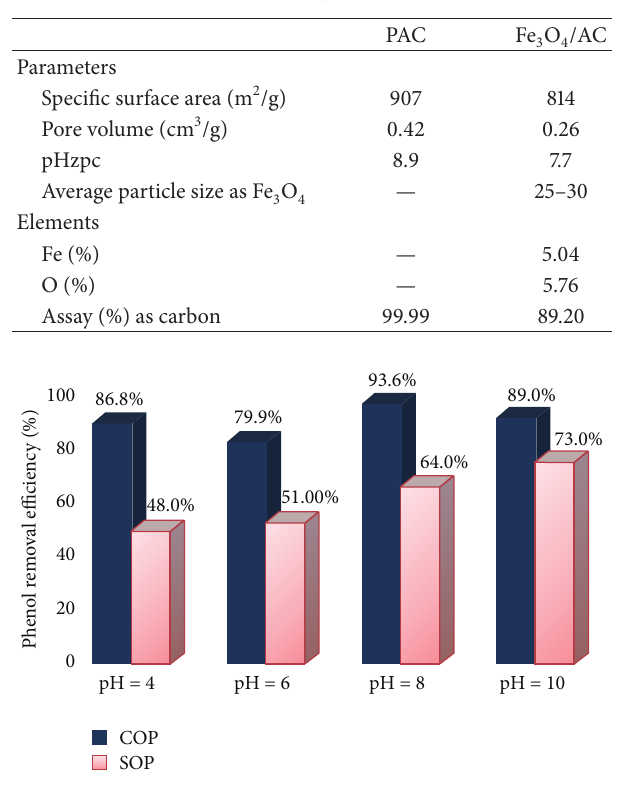
Table 2: Specifications of nano-Fe